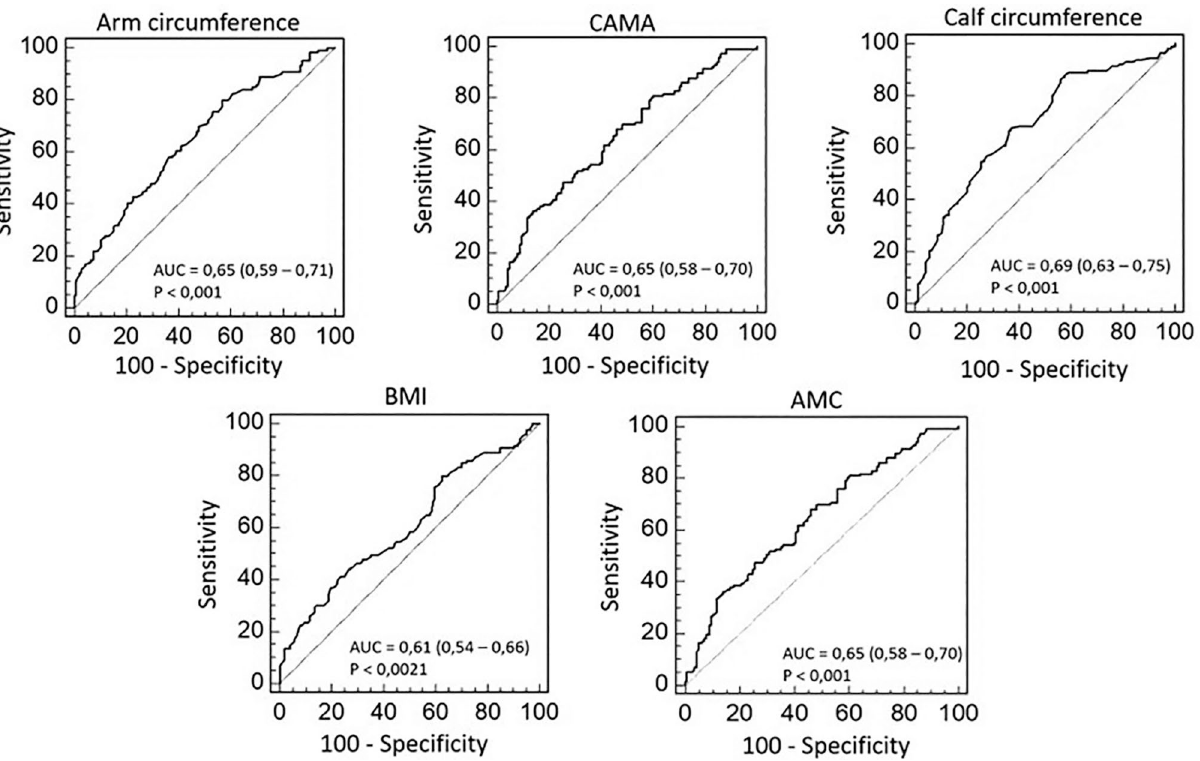
Figure 2 - ROC curves of anthropometric indicators as discriminators of dynapenia in middle-aged and elderly women. Jequié-BA, Brazil, 2017. CAMA: corrected arm muscle area; BMI: body mass index; AMC: arm muscle circumference; AUC: area under curve.